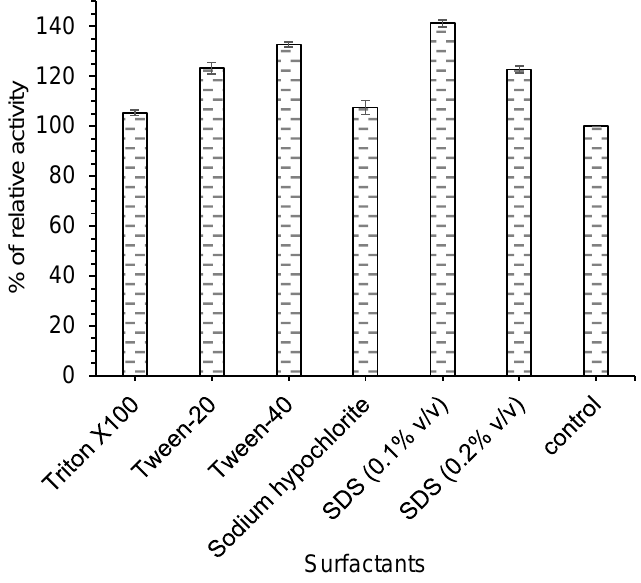
Figure 8. The effect of detergents, surfactant, and oxidizing agents on the crude amylase produced by Bacillus sp. BCC 021-50 after 1 h at 40 °C, pH 7.5. The results are shown as the percentage of relative activity compared to that of control (no additive). The experiments were performed in triplicate and the data presented in the figure are the average of three parallel experiments. Error bars are shown for standard